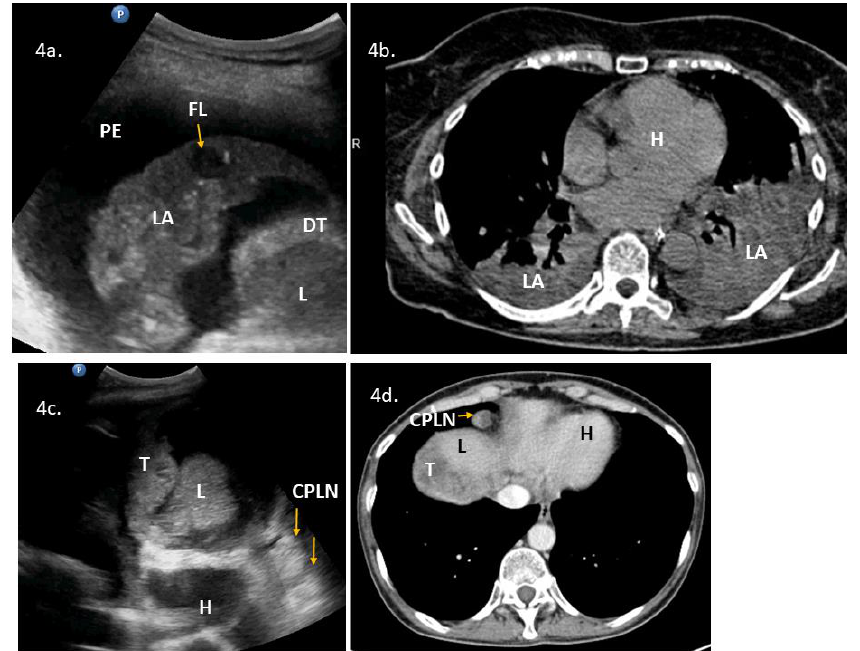
Figure 4. Lung ultrasonography and chest computed tomography (CT) of the lower parts of the pleural space and lungs: ( 4a ) ultrasound presentation of lung consolidation, a sonographic air bronchogram with inflammation, and a metastatic parenchymal lung lesion (arrow, FL), pleural effusions, and diaphragm thickening; ( 4b ) chest CT presentation of lung consolidation in the right and left lower lobes; and ( 4c ) ( 4d ) enlarged cardiophrenic lymph nodes (hyperechoic round lesions) on ultrasonography (3c) and chest CT (4d). Abbreviations: (CPLN) cardiophrenic lymph nodes; (DT) diaphragm thickening; (FL) focal lesion in the lung; (H) heart; (L) liver; (LA) lung with atelectasis; (T) tumor.